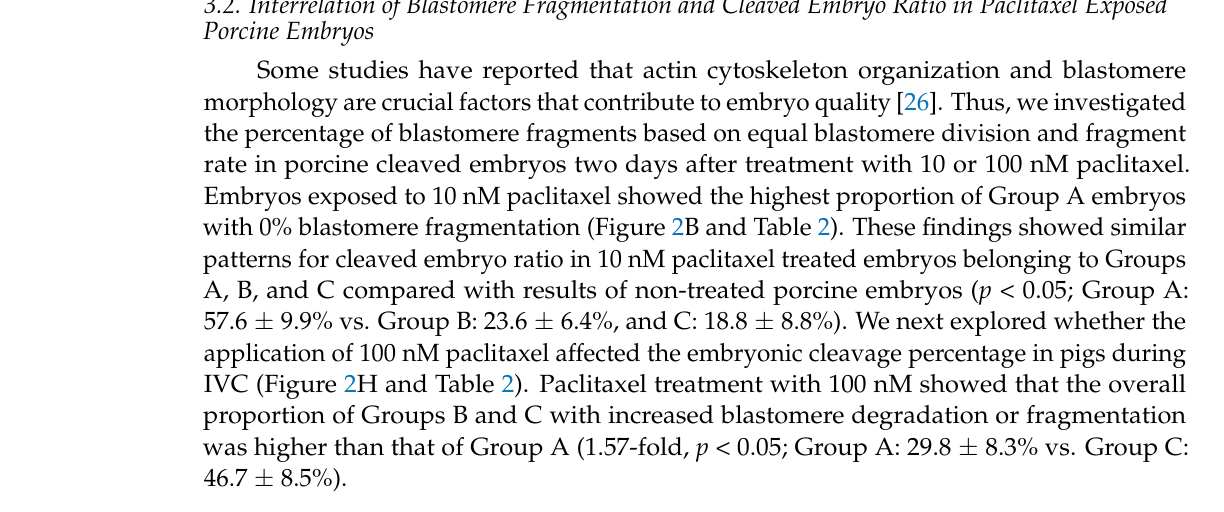
Table 2. Percentage of Groups A, B, and C in cleaved embryos following blastomere fragmentation by paclitaxel 10 and 100 nM